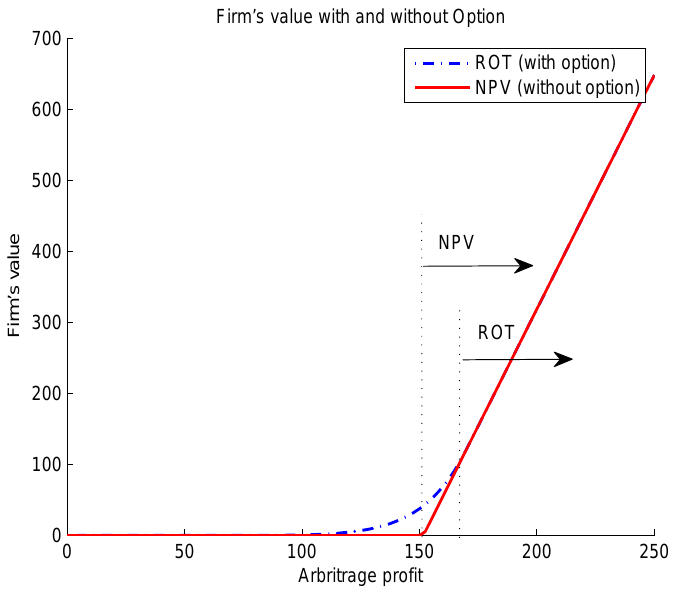
Figure 7. Comparison of ROT and NPV for small